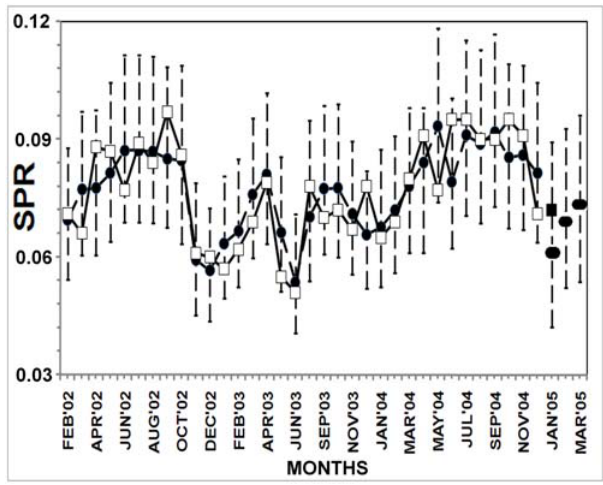
Figure 3. The plot of fit of the predicted values to the observed data of SPR values. Straight line with white squares-observed values of SPR; Dashed line with black circles-predicted values of SPR. Error bars are of 95% confidence intervals of the predicted response. Black ellipses-forecasted values of SPR (autoregressive forecasts) and Black square-observed SPR value for January, 2005.